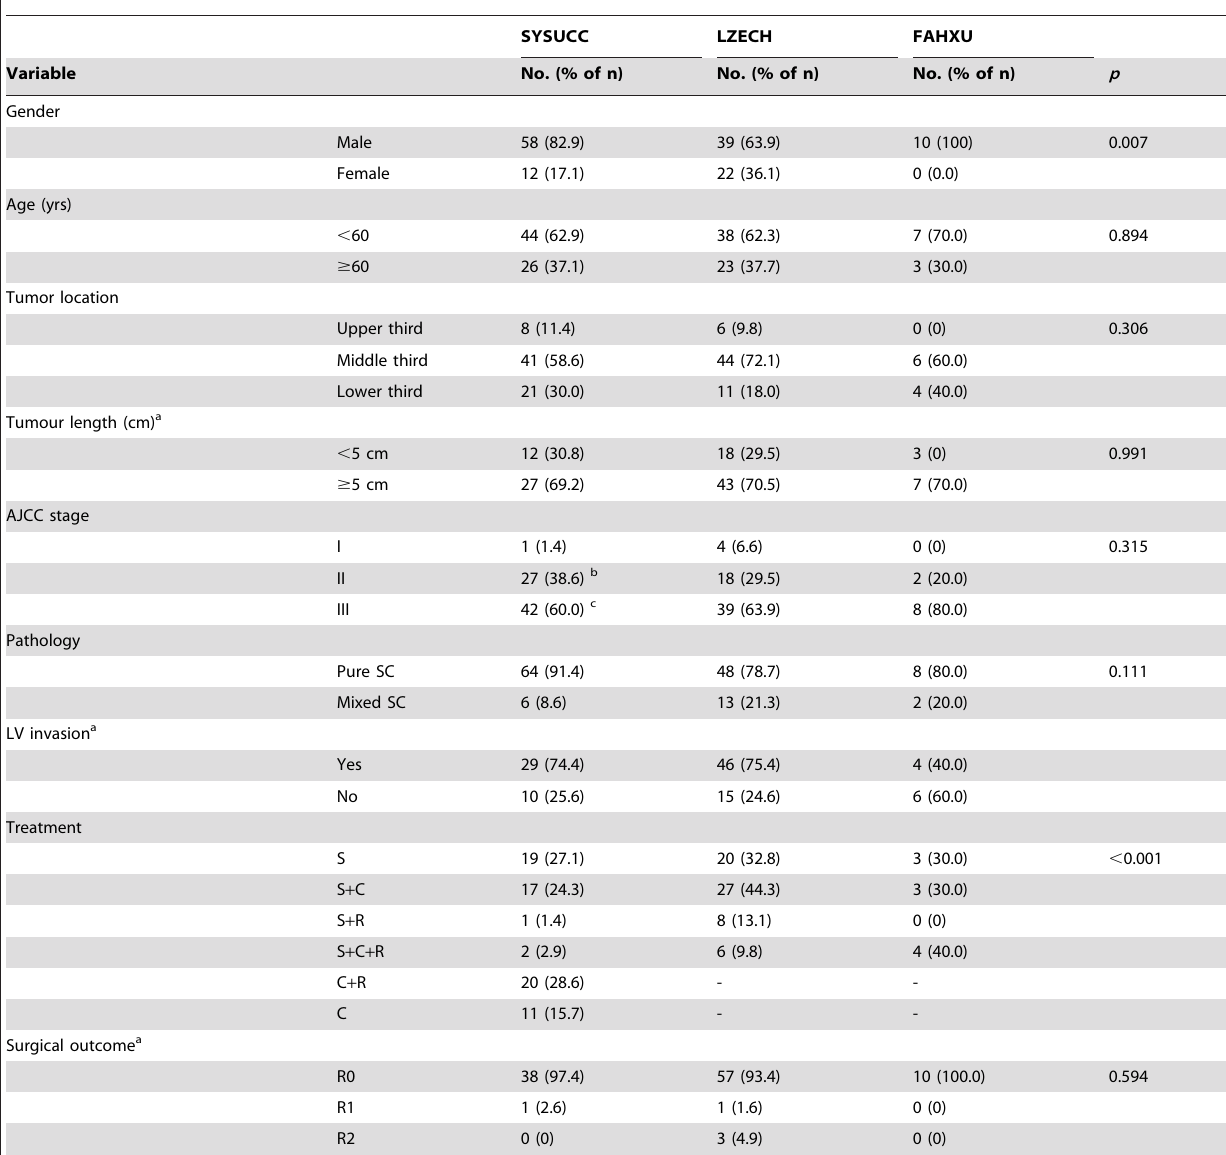
Table 1. Clinicopathological characteristics of the patients